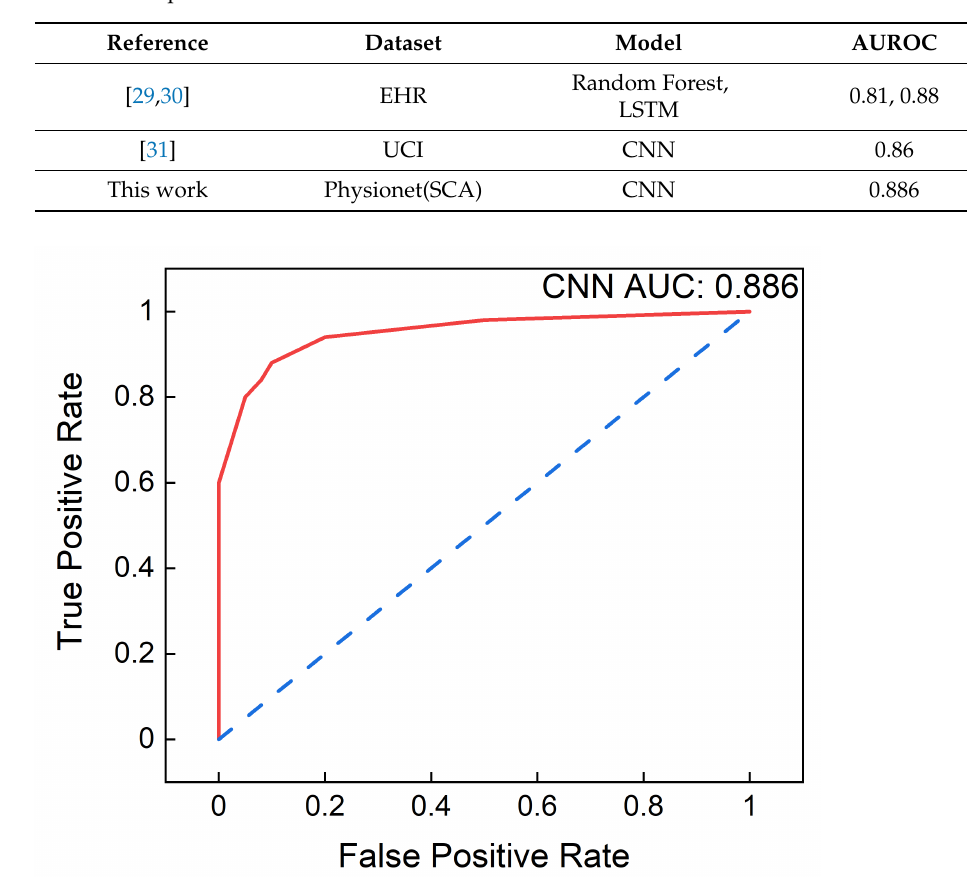
Figure 11. Area under the receiver operating characteristic curve of the CNN